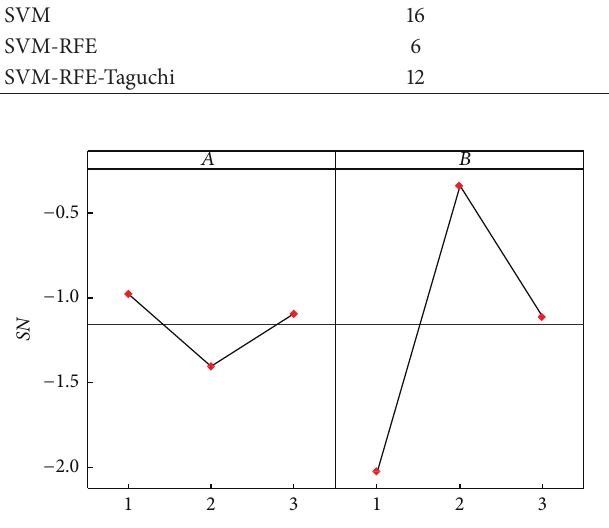
Figure 3: Main effect plots for 𝑆𝑁 ratio of Zoo database.